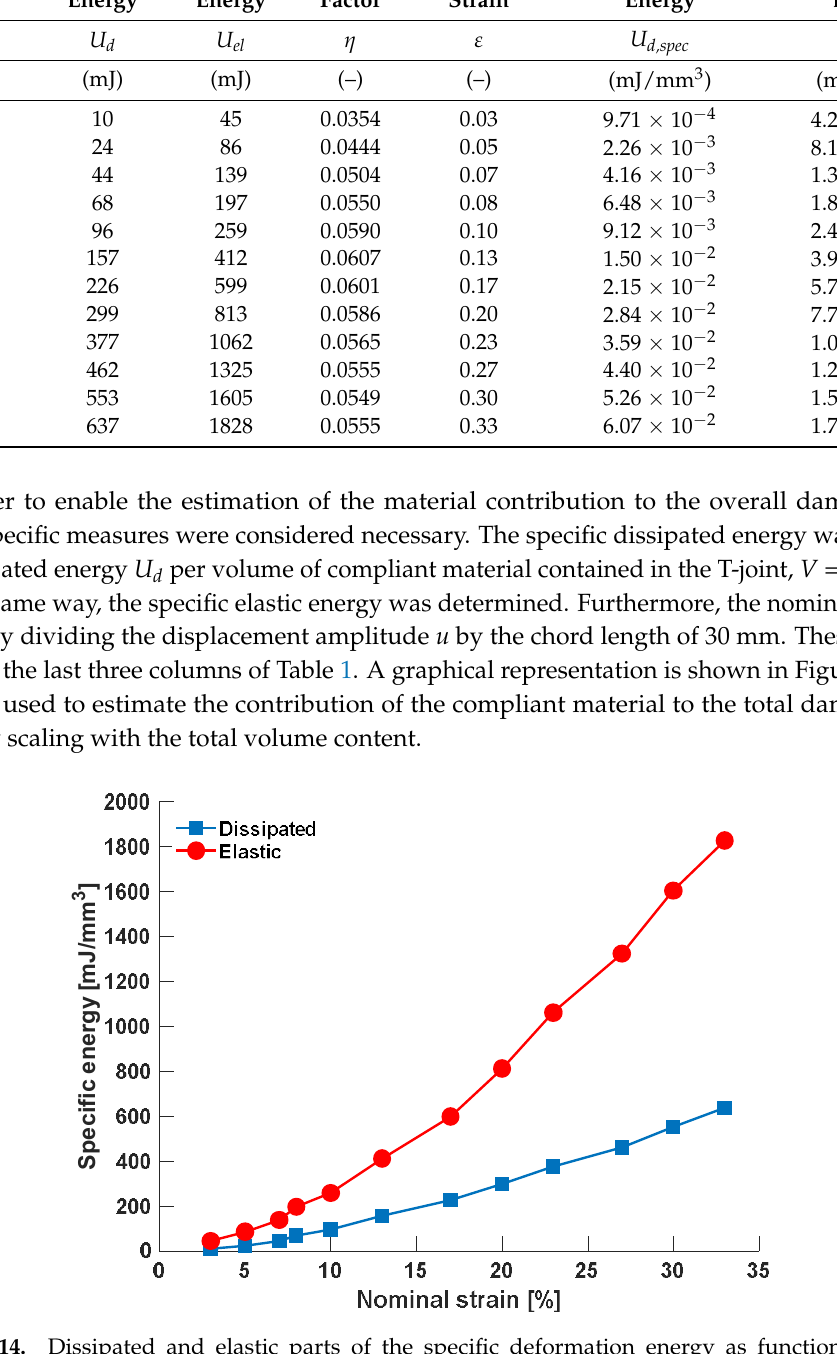
Table 1. Material damping properties obtained from ramped cyclic T-joint test.